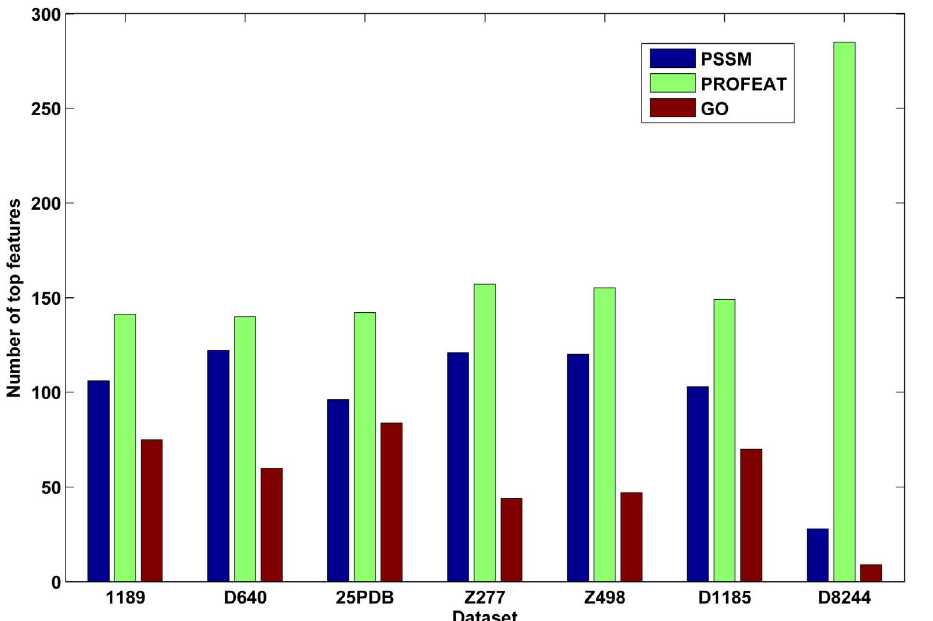
Figure 1. This graph shows the distribution of top322 features. SVM-REF ranked the features according to their ability to separate different categories for each dataset. So the ranking lists and top features are different for different datasets. Apparently, proportions of different kinds of features are consistent for all seven datasets, i.e., physical-chemical properties reflected by PROFEAT constitute the majority group, followed subsequently by PSSM and GO annotation features. The bar chart shows the numbers of three different kinds of features in top features for each dataset.